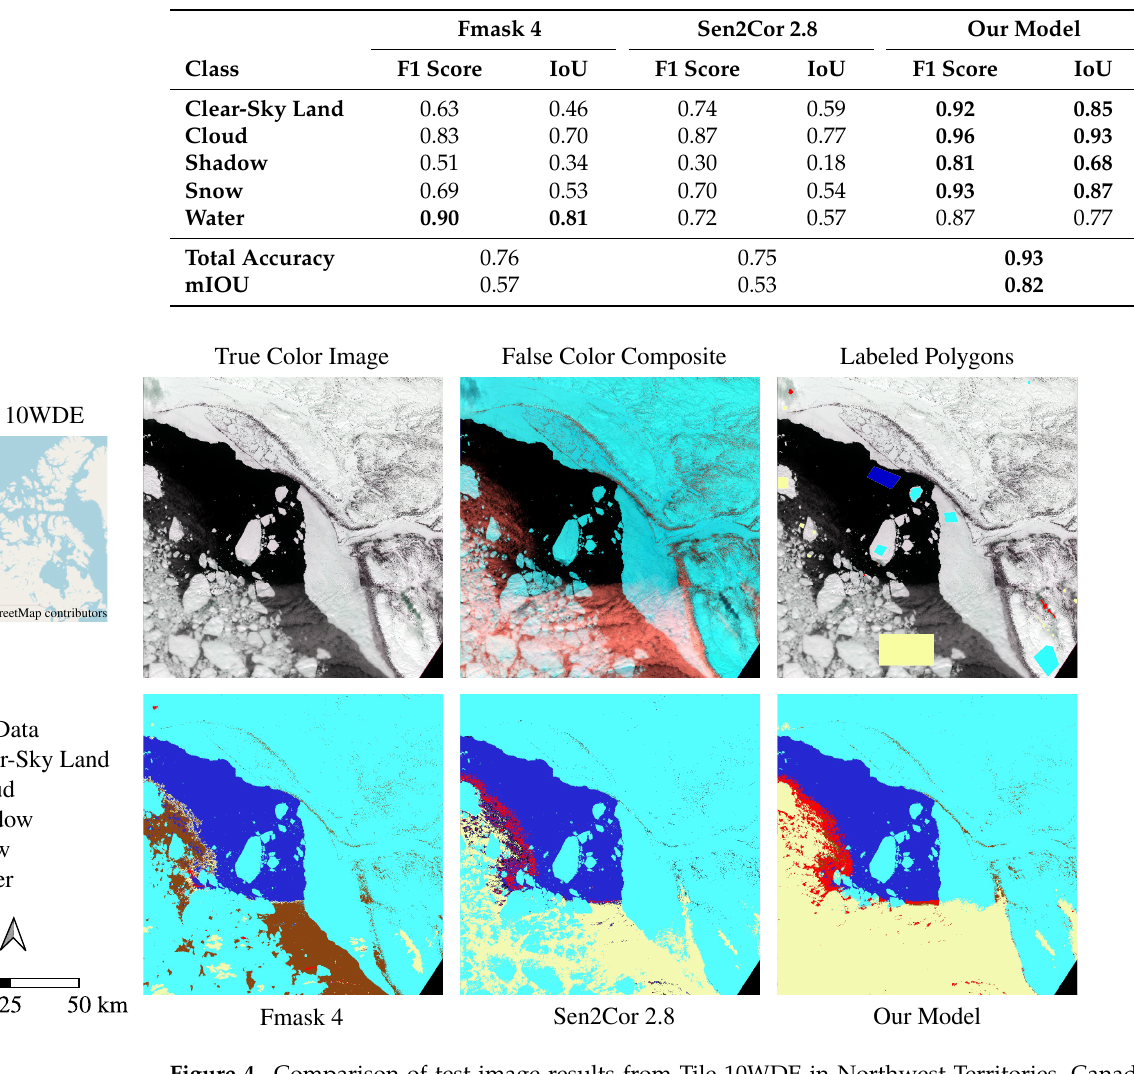
Figure 4. Comparison of test image results from Tile 10WDE in Northwest Territories, Canada, captured on 1 June